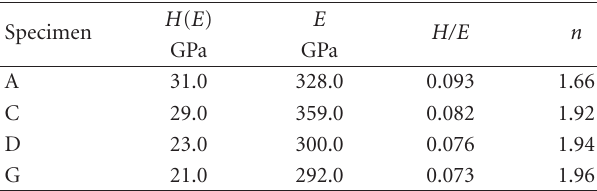
Figure 6: Representative indentation response curves measured during the nanoindentation measurements on the unimplanted (specimen A), and fluorine-implanted (specimen C, D, and G) hot- pressed boron suboxide specimen. Table 2: A summary of the e ff ect of ion implantation on H ( E ), E , the ratio H/E , and the Meyer’s index n